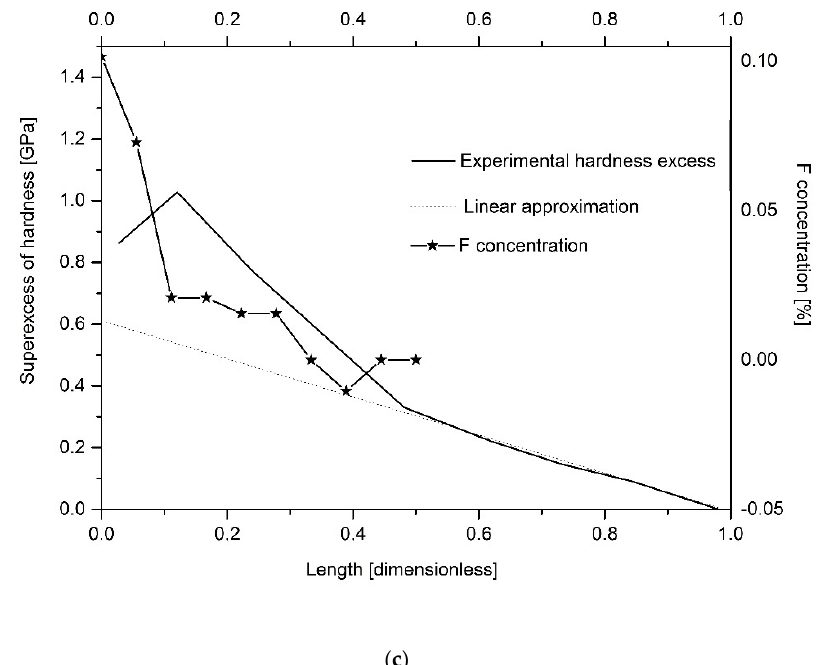
Figure 4. ( a ) Profiles of the atomic relations occurring in the “overbuilt” enamel; the atomic ratios are recalculated per 1 Ca atom for: P—solid line with full triangles; Na—solid with open circles; Mg—solid; Cl—solid with stars; CO 32 − —solid with full squares; ( b ) the same for fluoride, compared with chloride, on a shortened distance corresponding to locations where F is easily detected; ( c ) the comparison of the absolute concentration of F (solid line with stars) with the additional excess of hardness value (solid line) close to the boundary with air.